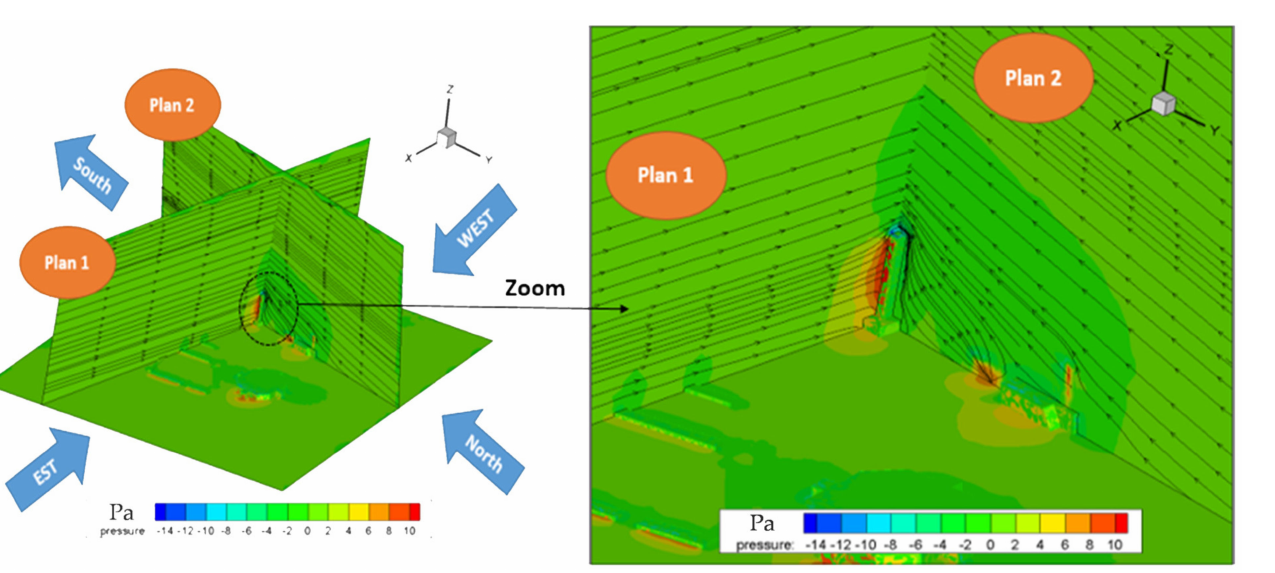
Figure 10. Streamline and axial velocity contours in the vicinity of the Hail